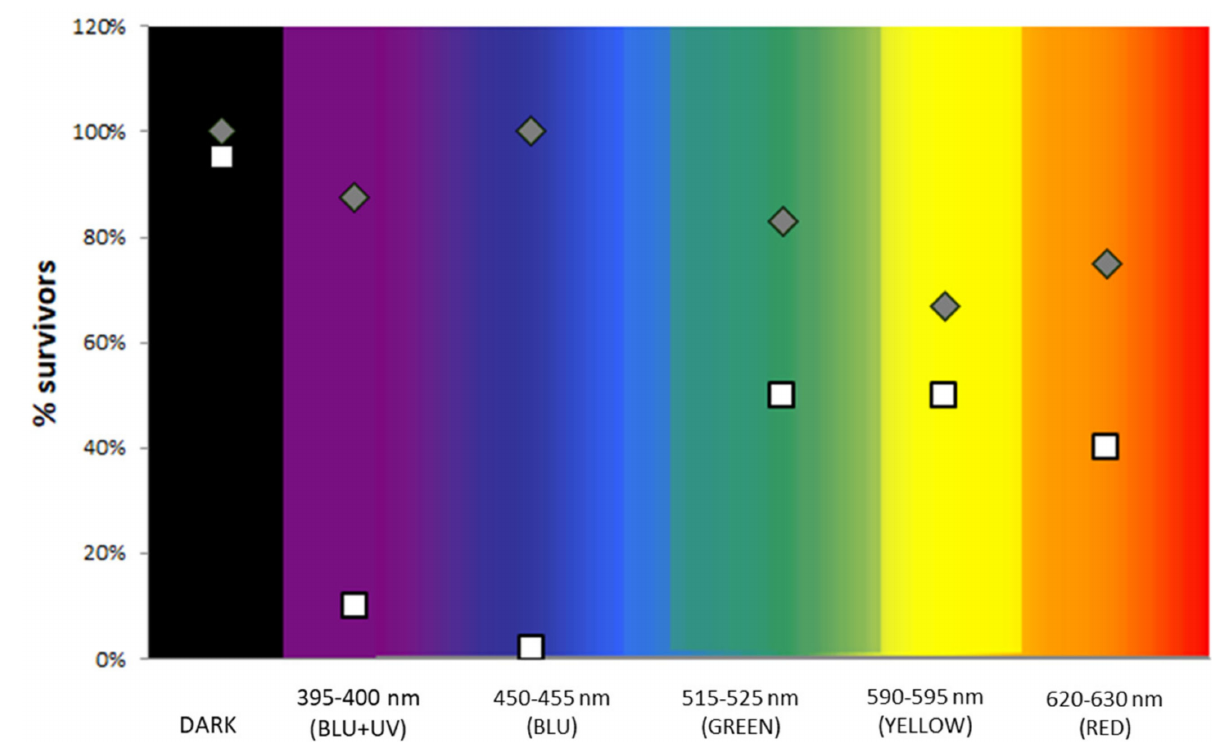
Figure 4. Photocatalytic effectiveness of micrometric TiO 2 coated masks at different wavelengths. Experimental con- tamination of cloth face masks, previously with coated (white square) or without coated (grey rhomb) TiO 2 microparticles. Data are expressed as the percentage of survival on agar plates, after 15-min exposures at several wavelengths of the visible spectrum, and using dark (not light exposure) as a control. UV (395–400 nm) and blue light wavelength (450–455 nm) show the highest antibacterial activity (98–100%).